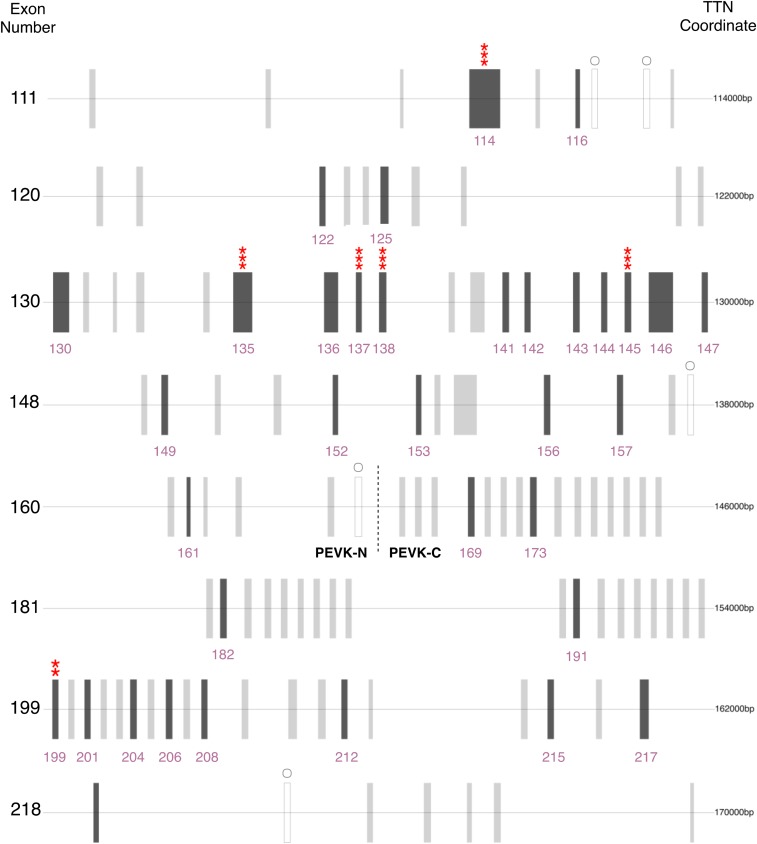
Human PEVK_Finder exon-intron plot depicting orthologous exons and codons under significant positive selection. Dark gray bars (labeled with their respective exon numbers) indicate orthologous exons, gray circles indicate exons missed by PEVK Finder, and asterisks indicate codons under selection at varying levels of significance. Asterisks indicate posterior probabilities of * > 0.5; ** > 0.75; *** > 0.95. The probability for only the most significant codon for a given exon is noted. Exons 114, 116, 122, 125, 130, 135, 136, 137, 138, 141, 142, 143, 144, 146, 152 153, and 161 are either constitutively expressed or expressed in >95% of TTN transcripts in skeletal muscle according to Savarese et al. (2018). Details about codons under selection are in Figures S5–S12. As in figure 1c, the first exon in this figure is technically outside the pre-defined bounds of the human PEVK region.